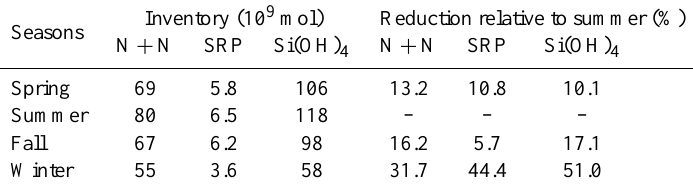
Table 1. Summary of the area-integrated nutrient inventories in the upper 100m of the water column in the central northern South China Sea.